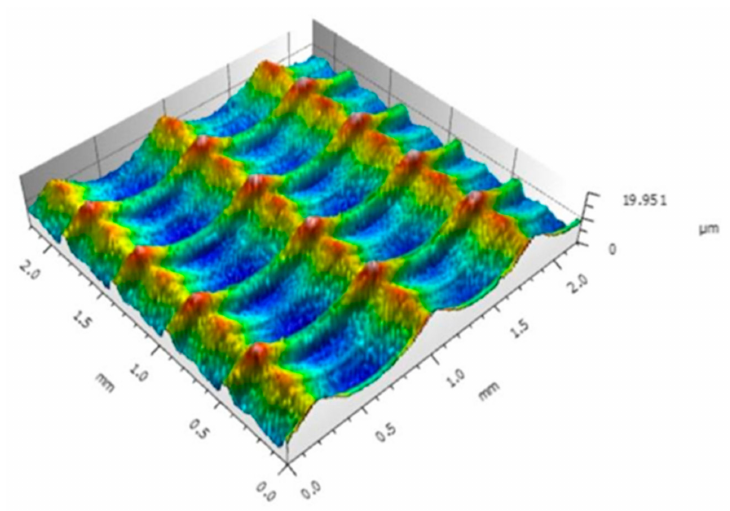
Figure 5. Observation results of surface morphology of quadrilateral pits.